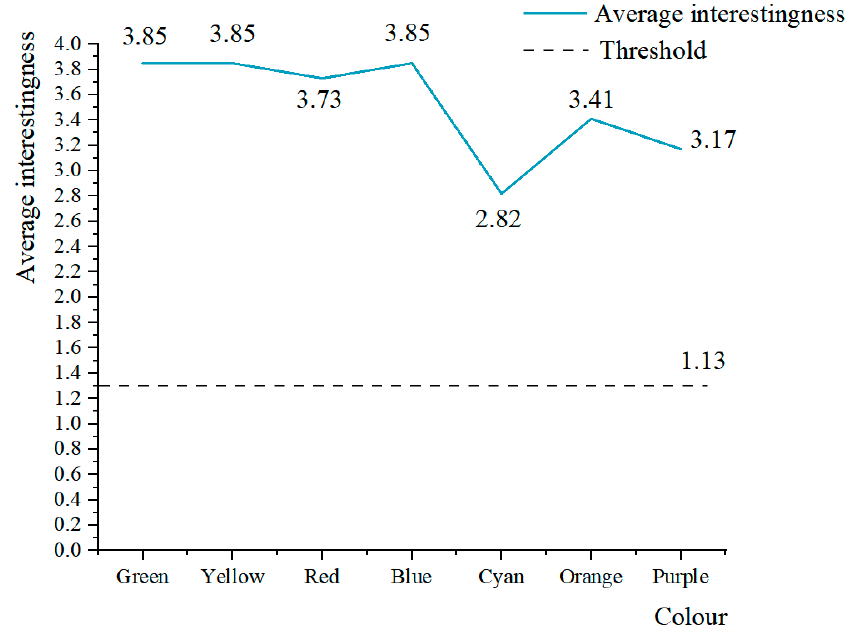
Figure 8. Overall mean variation trend of interest degree of 78 subjects. Source: ErgoLAB platform derived the data, and the weight threshold of level of interests was 1.13 when the duration of fixation was the longest. Due to the weak visual presentation of the variation trend of individual landscapes’ colour interest, the average trend chart of seven categories of landscapes’ colour interest of 78 subjects was made as an assistant.